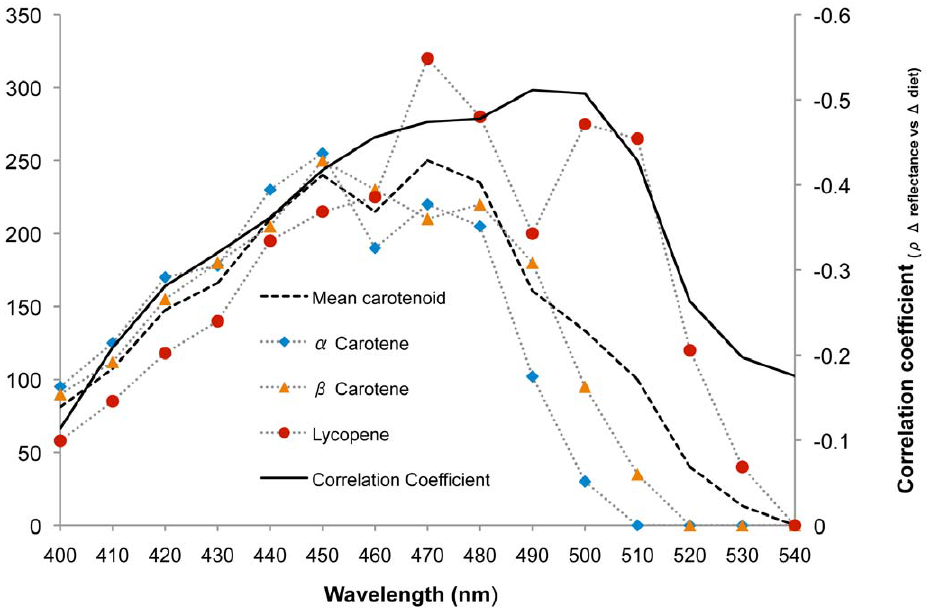
Figure 6. Diet-linked facial skin reflectance changes track common carotenoids. Solid black line - Spearman correlation coefficients ( r D reflectance vs D diet ) of the relationships between fruit and vegetable consumption change (from week 0 to 6) and facial skin reflectance change. Dashed bold line shows the mean absorption spectra [cm 2 1 (mg/ml) 2 1 ] for three common carotenoids, which are individually plotted (blue rhombi - a - carotene, orange triangles - b -carotene and red circles - lycopene). doi:10.1371/journal.pone.0032988.g006 PLoS ONE |